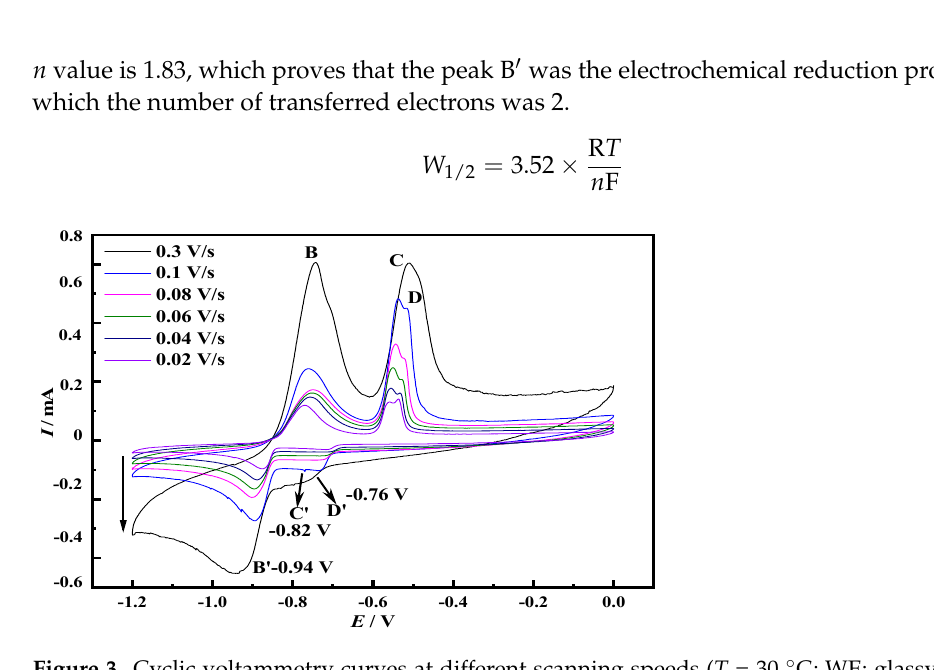
Figure 3. Cyclic voltammetry curves at different scanning speeds ( T = 30 °C; WE: glassy carbon electrode; CE: platinum; RE: Hg/HgO (0.098 V); scan rate: 0.02–0.3 V/s).